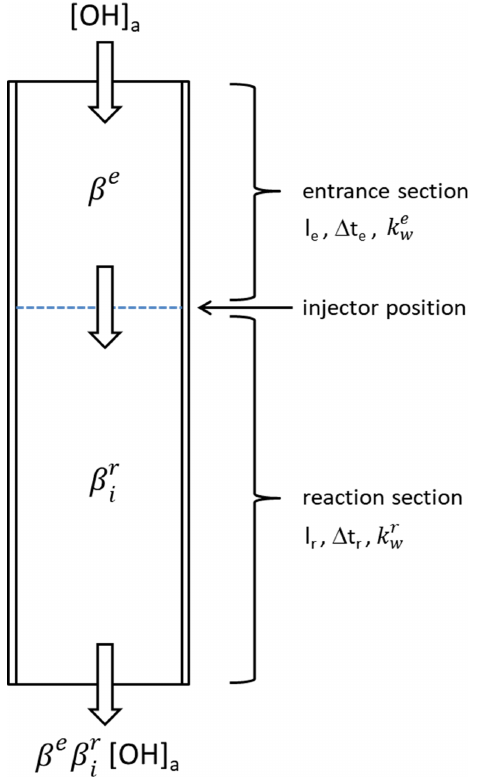
Figure 2. Schematic of the chemical modulation reactor (CMR). The flow tube has an entrance section with a length l e up to the in- jector position. In this section, OH radicals are lost by wall reaction during the transit time (cid:49)t e with a rate coefficient k e w , resulting in an OH transmission β e . Behind the injector position follows the reac- tion zone, where OH is scavenged when propane is injected into the flow. The reaction zone has a length l r with a transit time (cid:49)t r and wall loss rate coefficient k r w . The OH transmission β r in the reaction i section depends on the chemical modulation mode (i = N 2 when pure nitrogen is injected and i = sc when a scavenger–nitrogen mix- ture is injected). The total transmission for OH is given by the prod- uct β e β r . i